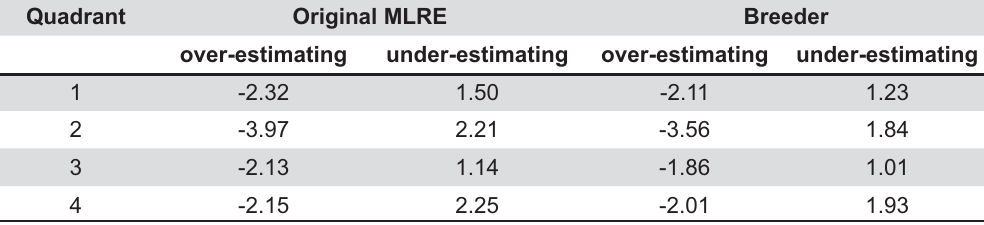
Table 5- Maximum errors in estimating the sum of the mesiodistal sizes of unerupted canines and Quadrant